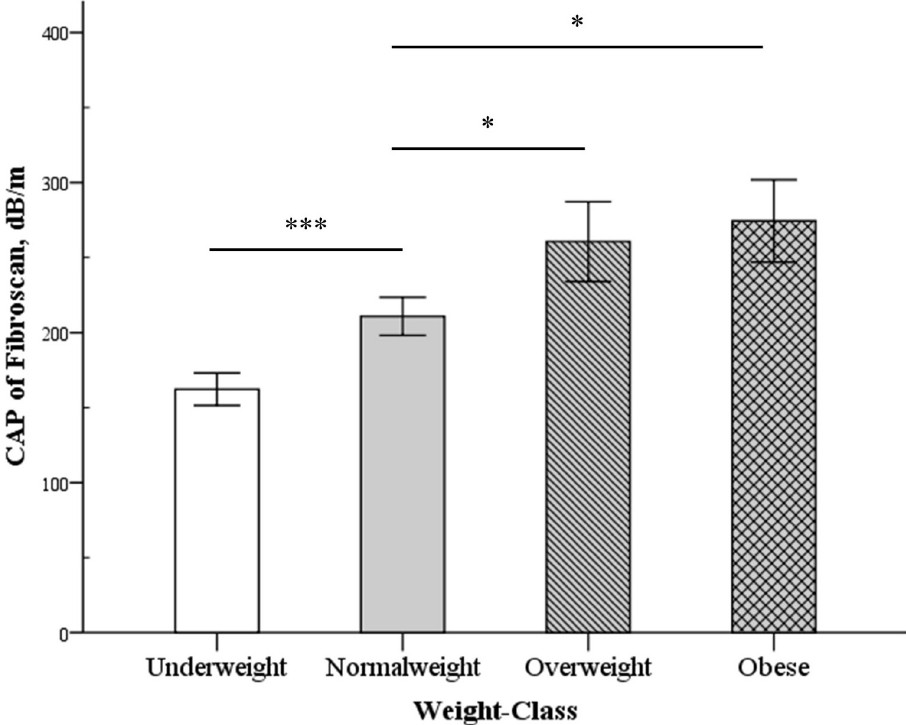
Fig 1. Differences in the FibroScan controlled attenuation parameter (CAP) scores (vertical line) between the different weight classes (horizontal line). Data are expressed as mean ± standard error. � P < 0.05 and ��� P < 0.001.